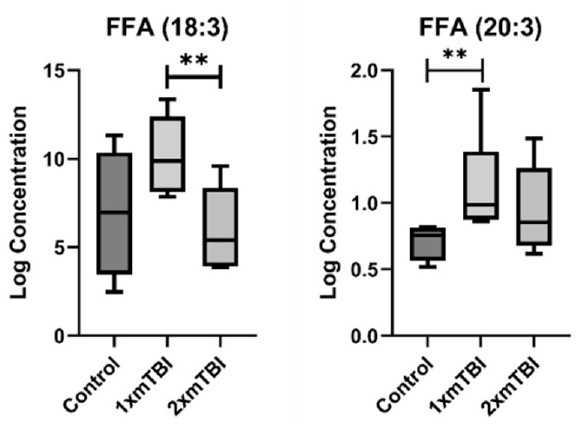
Figure 3. Lipids that change with one injury vs. sham control. Boxplots represent the minimum, first quartile, median, third quartile, and maximum, for the control, 1 × mTBI and 2 × mTBI groups. Significant differences between groups are indicated above the boxplots by ** ( p < 0.05) or ** ( p < 0.01). FFA, free fatty acid; mTBI, mild traumatic brain injury.